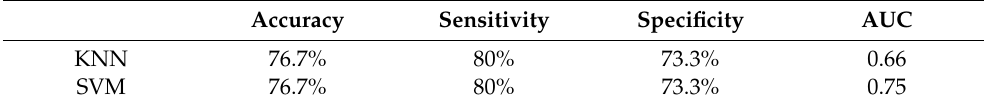
Table 6. Evaluation of classification performance for Fp1 channel.